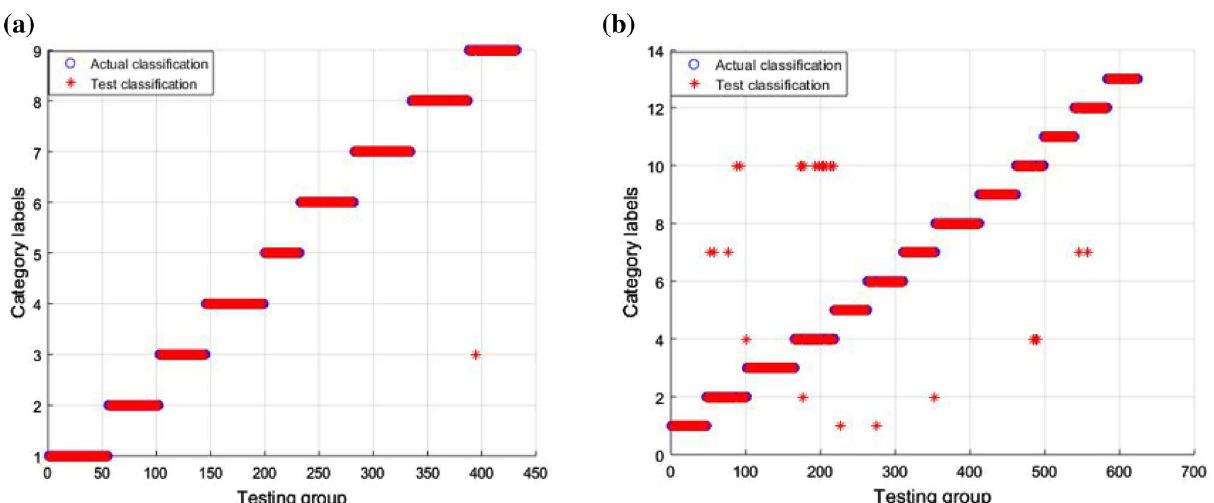
Figure 9. Fault classification result in GA-SVM: ( a ) classification result for Case 1; ( b ) classification result for Case